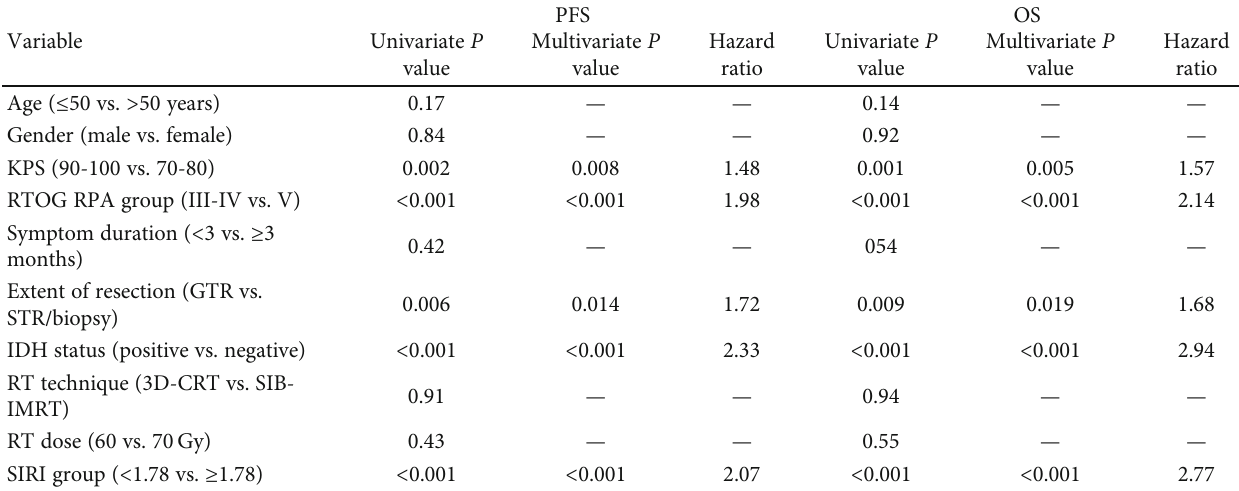
Table 4: Results of uni- and multivariate